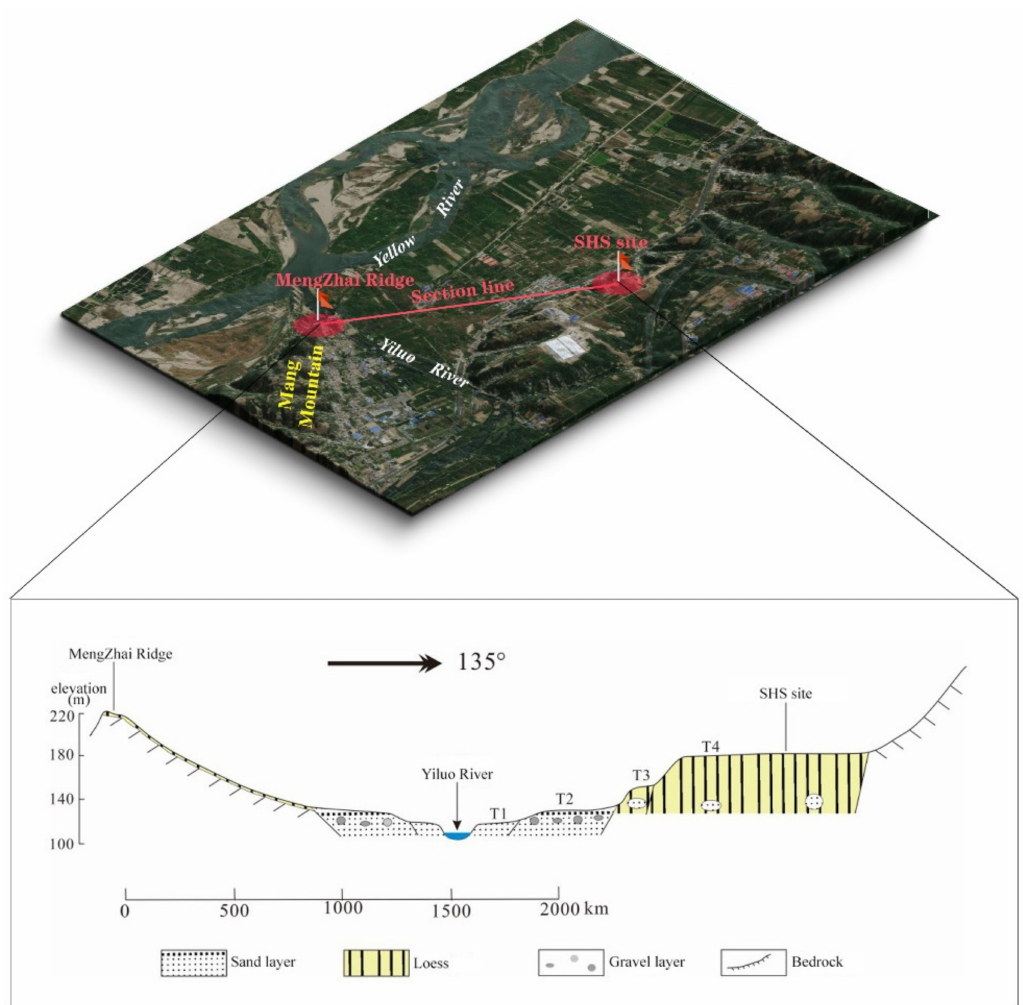
Figure 10. Surrounding environment and profile of the SHS site.